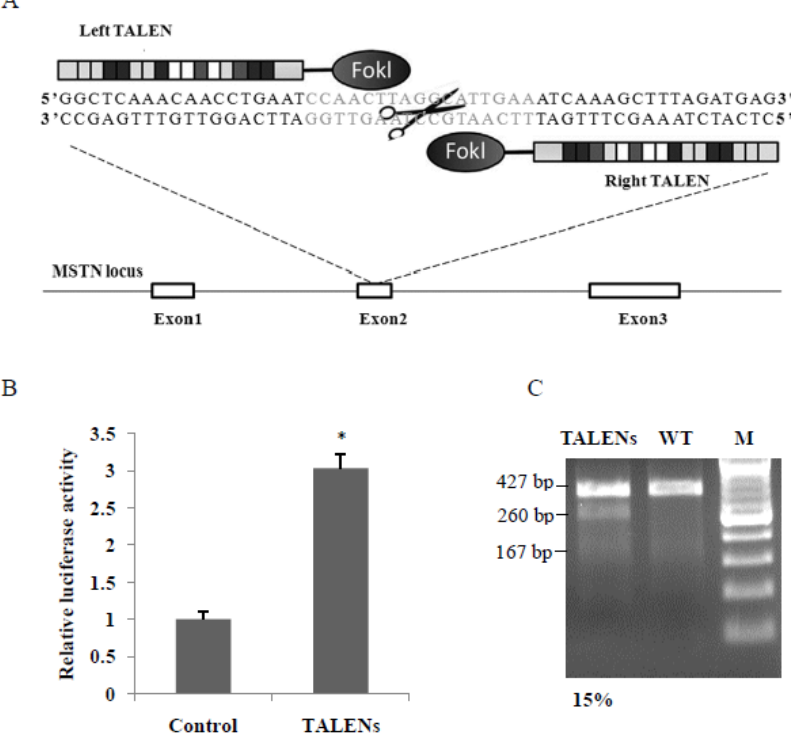
Figure 1. Design and activity of transcription activator-like effector nucleases (TALENs). (A) Schematic representation of TALENs targeting sheep myostatin (MSTN). The coding regions are indicated by white boxes. A TALEN consists of a nuclease domain (Fok I) and a DNA binding domain (TALE proteins), and the recognition sequences of the TALE proteins are blue. (B) TALENs activity was measured by luciferase SSA reporter assay. * p<0.01. (C) Surveyor nuclease assay for detecting TALEN activity. MSTN, myostatin; TALEN, transcription activator-like effector nuclease, polymerase chain reaction (PCR) products from TALEN-treated cells; SSA, single-strand annealing; WT, wild-type PCR